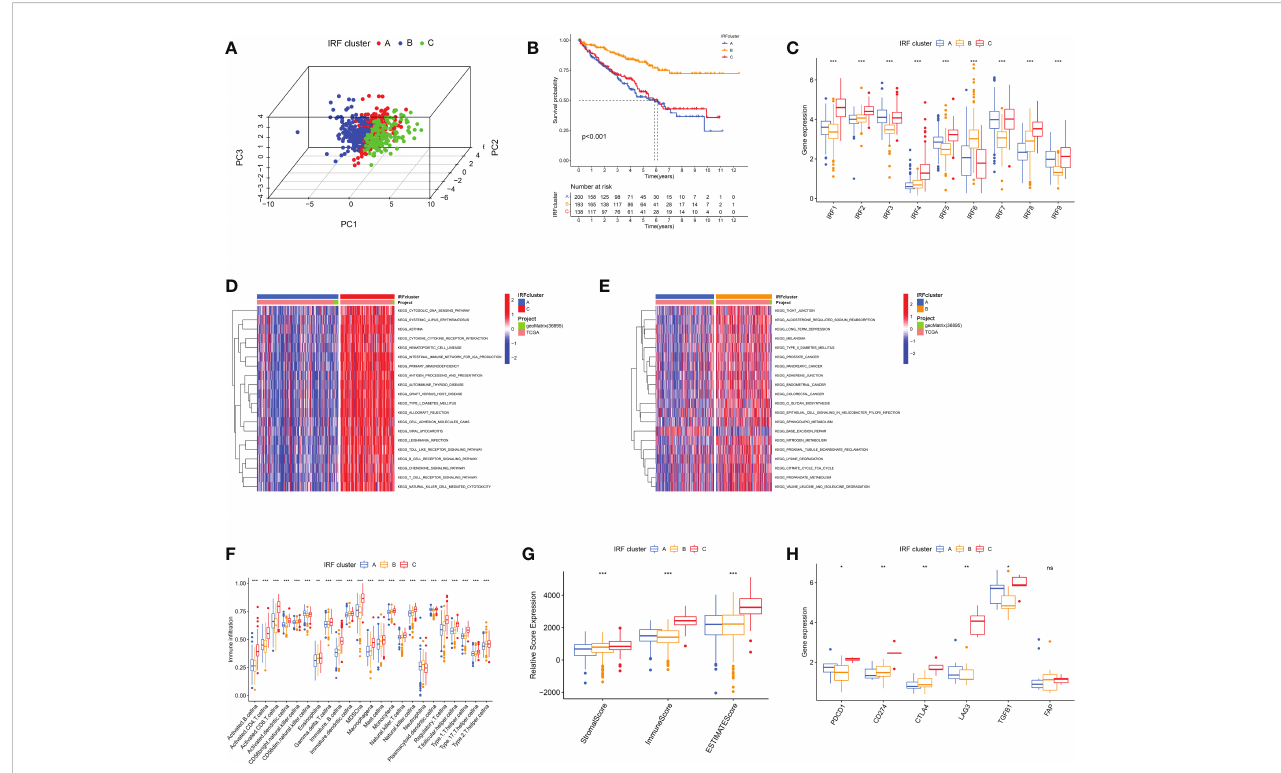
FIGURE 3 The IRF-related molecular subtypes in ccRCC and biological and immune characteristic of each pattern. (A) PCA for the transcriptome pro fi les of three IRF clusters. (B) Survival analyses of three IRF clusters. (C) The expression of IRF1-9 in three IRF clusters. (D-E) GSVA enrichment analysis showing the activation states of biological pathways in distinct clusters. (F) The abundance of each TME in fi ltrating cell in three clusters. (G) Box plot indicated the correlation between IRF clusters and immune scores, stromal scores and estimate scores. (H) The expression of most immune checkpoints among distinct IRF clusters. ns, not signi fi cant; *p < 0.05; **p < 0.01; ***p < 0.001.